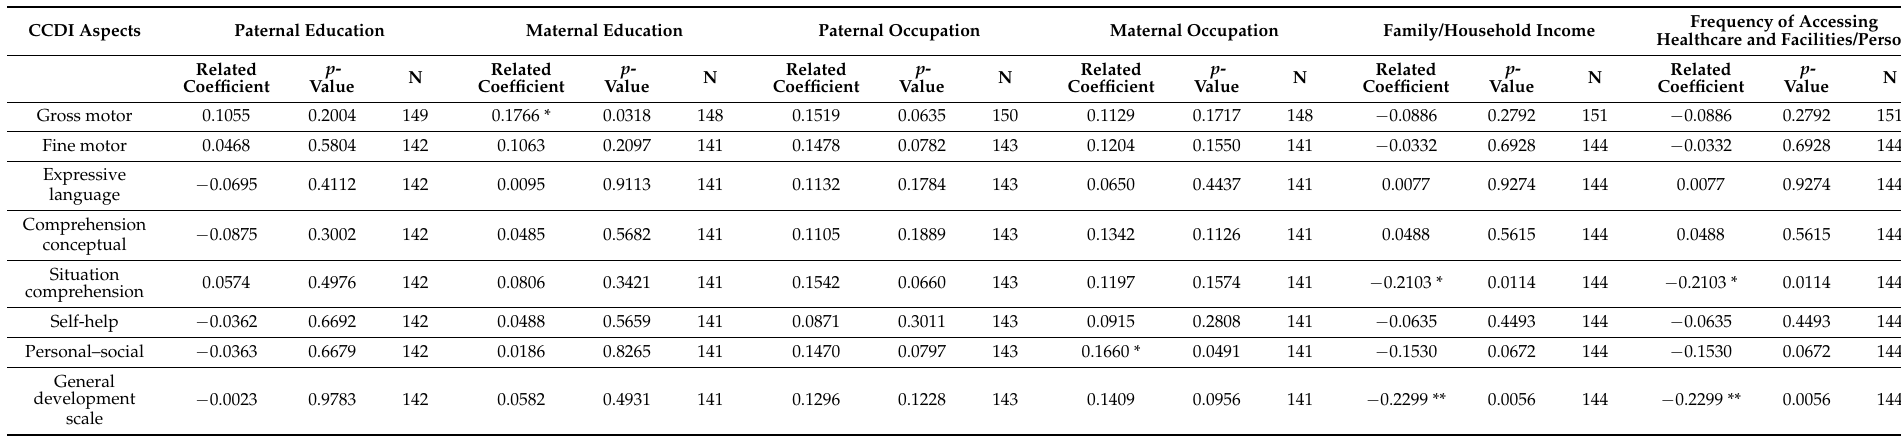
Table 2. The statistical analyses for the significance between the SES measures and certain CCDI